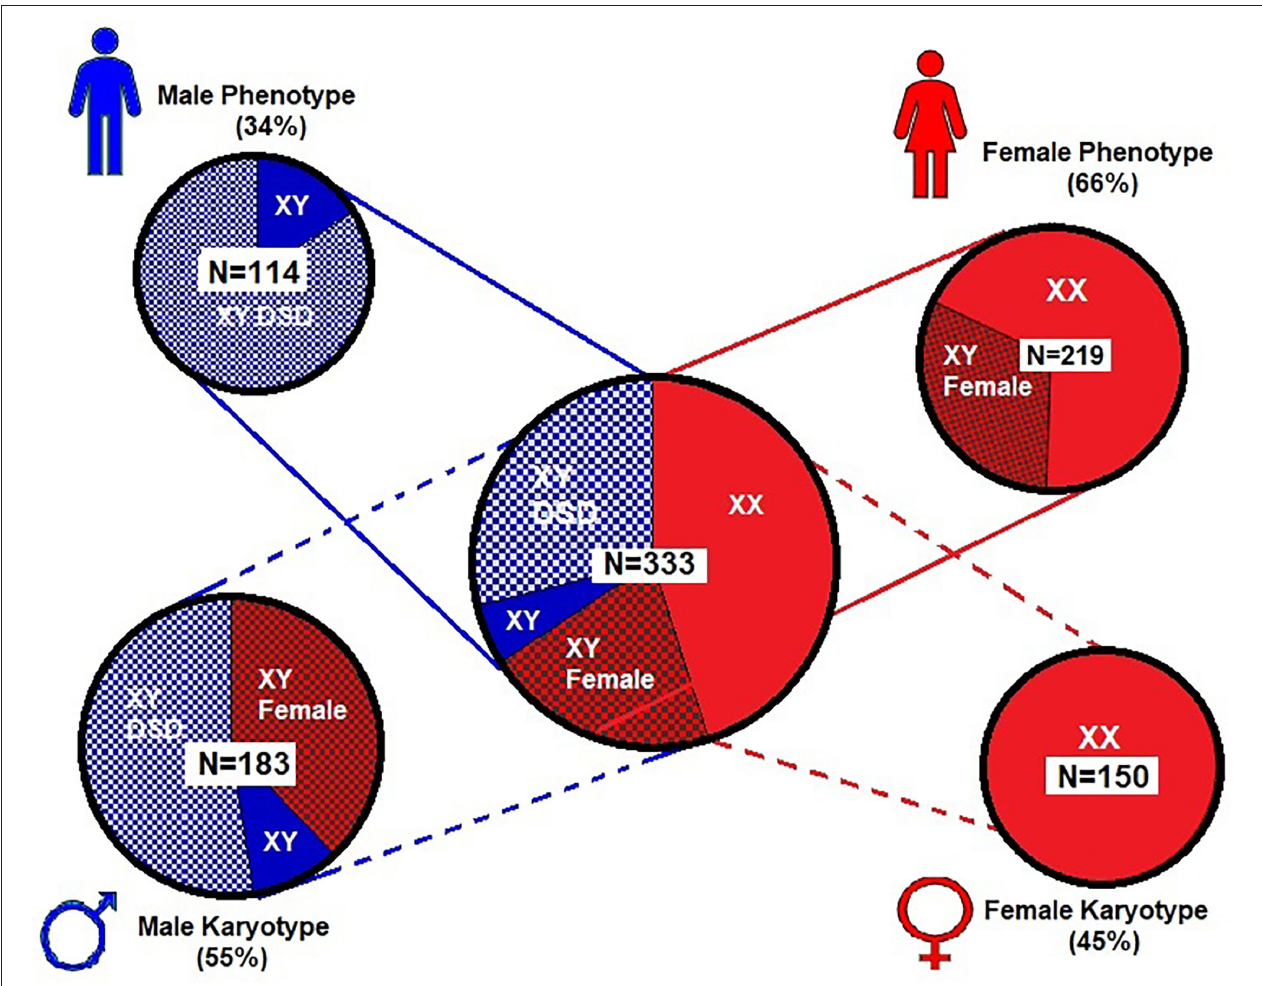
FIGURE 2 | Proportional distribution of phenotype–karyotype for 333 subjects from literature review and our case series. Female (XX) karyotype is only 45% of the entire series while the male (XY) karyotype predominates (55%) and includes predominantly males with disorders of sexual development (DSD). However, the female phenotype was nearly two times that of the male phenotype and includes those with 46 XY sex reversal. For graphic clarity, the phenotype is represented by the male and female iconic figures in blue and red, respectively . The karyotypes are graphically represented by the male and female gender icons in blue and red, respectively